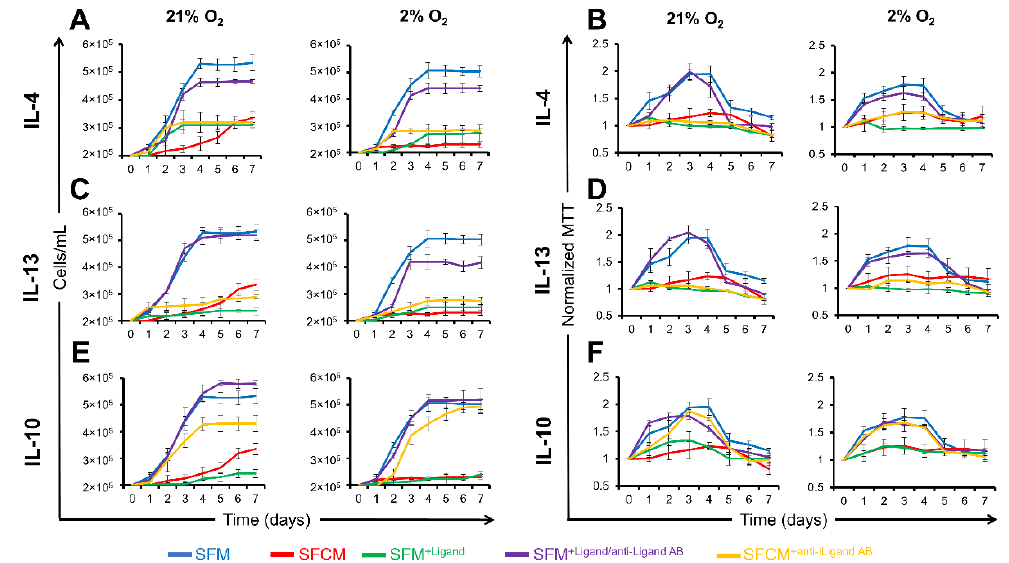
Figure 3. Proliferation of non-polarised Jurkat T cells is restored in IL-10-devoid SFCM. Growth curve plots calculated from cell counts of non-polarised Jurkat T cells cultured in SFM, SFCM, SFM +Ligand , SFM +Ligand/antiLigand AB , and SFCM +antiLigand AB in air (21% O 2 ) and physoxia (2% O 2 ) environments over a 7 day period. ( A ) IL-4, ( C ) IL-13, and ( E ) IL-10. Data expressed as mean ± SD ( n = 3). Optical density (O.D.) values for MTT assays of non-polarised Jurkat T cells cultured in SFM, SFCM, SFM +Ligand , SFM +Ligand/antiLigand AB , and SFCM +antiLigand AB in both air (21% O 2 ) and physoxia (2% O 2 ) environments over a 7 day period. ( B ) IL-4, ( D ) IL-13, and ( F ) IL-10. MTT assay values at each time point were normalised to day 0. Data expressed as mean ± SD, ( n = 3).